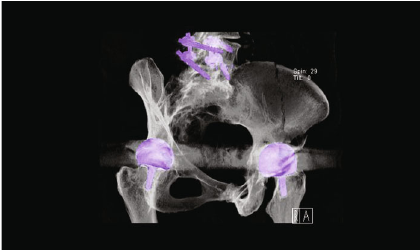
Figure 3: CT volume rendering of the pelvis. The reconstruction of all CT planes gives an overview of the fracture of the Os ilium and the extent of the